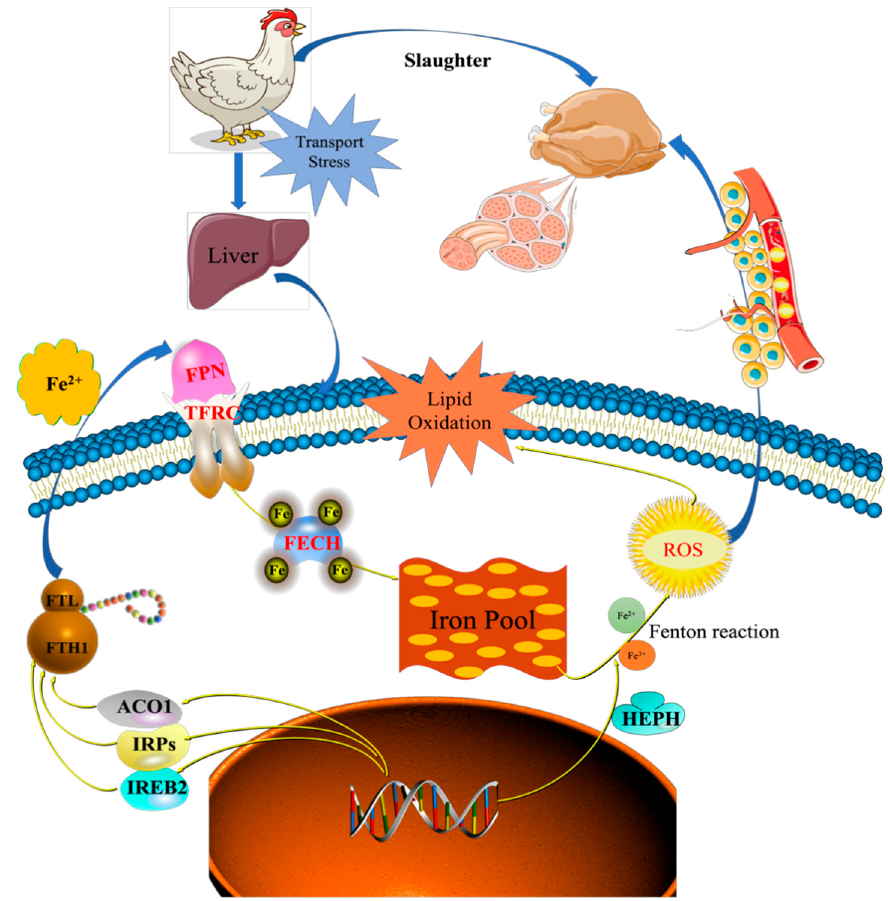
Figure 7. Proposed molecular mechanisms of transport stress-induced imbalance in iron homeostasis. SLC40A1, Solute carrier family 40 protein; TFRC, Transferrin receptor; FECH, Ferrochelatase; FTL, Ferritin, Light polypeptide; FTH1, Ferritin Heavy chain 1; ACO1, Aconitate hydratase 1; IREB2, Iron responsive element binding protein 2; HEPH, Hephaestin.